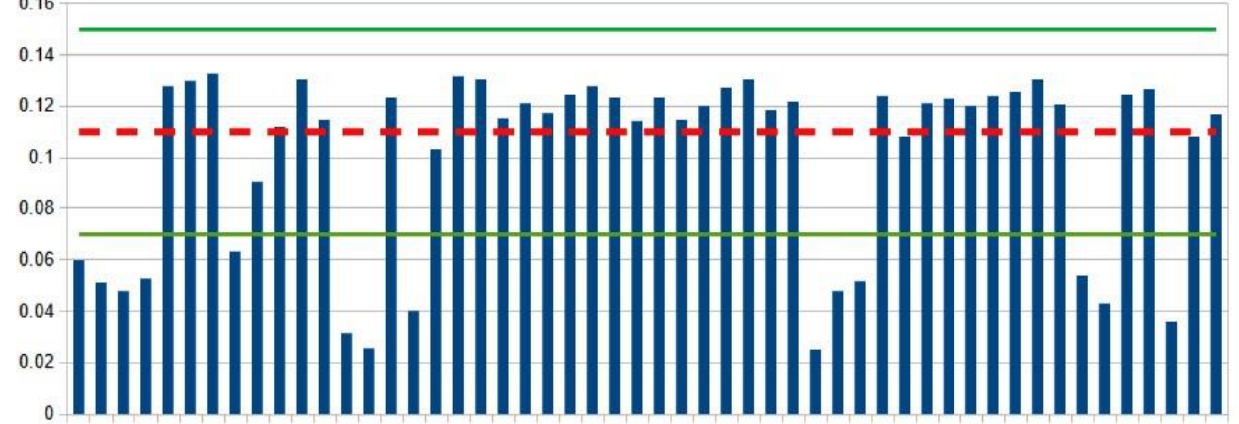
Figure 3. Polyunsaturated protons to glycerol C2 proton ratio of market survey samples. The mean ratio of baseline samples is depicted with a dashed red line, green lines are the mean plus or minus two standard deviations.